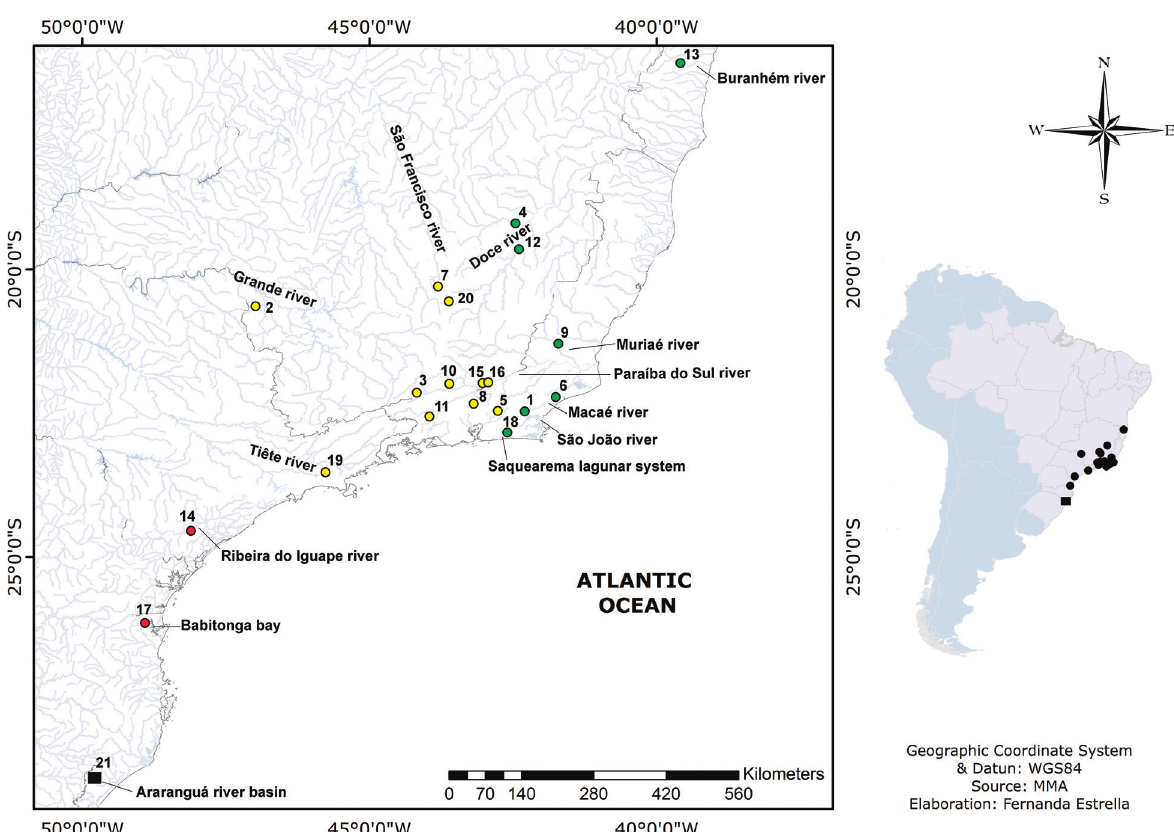
Figure 1. Map of the samples obtained for the present work. Circles = Australoheros autrani species group; Red circles = Southern Mata Atlântica clade; Yellow circles = Upper/middle Paraíba do Sul river basin and adjacent drainages clade; Green circles – North - ern Mata Atlântica clade; and Square = A. sp. Timbé do Sul. Localities: A. autrani = 1 and 18, A. barbosae = 2, 3, 10, 11 and 19, A. ipatinguensis = 4, A. macacuensis = 5, A. macaensis = 6, A. muriae = 9, A. perdi = 12, A. ribeirae = 14, A. robustus = 7, 8, 15, 16 and 20, A. sanguineus = 17, A. cf. capixaba = 13, and A. sp. Timbé do Sul =